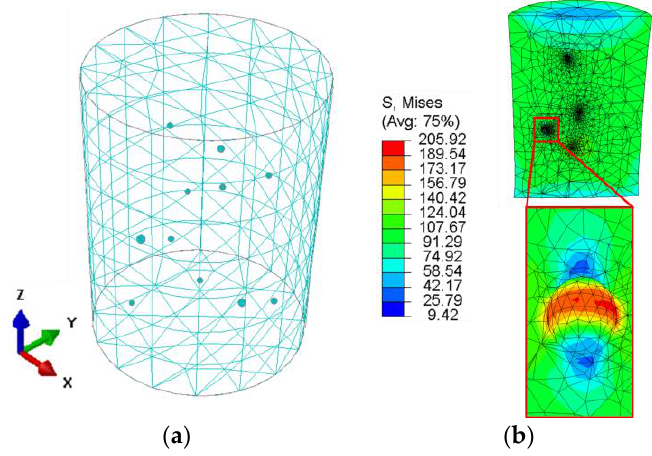
Figure 5. Finite-element analysis of batch C (Scalmalloy ® LMD) under 100 MPa of stress amplitude: ( a ) Model; ( b ) Z-plane cross-sectional peak-stress distribution, around pores under uniaxial cyclic